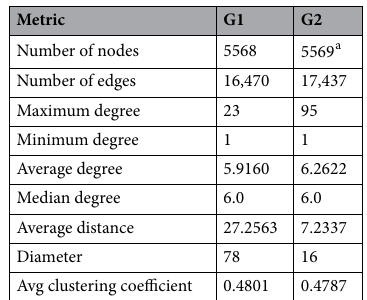
a Fernando de Noronha was added to the network.